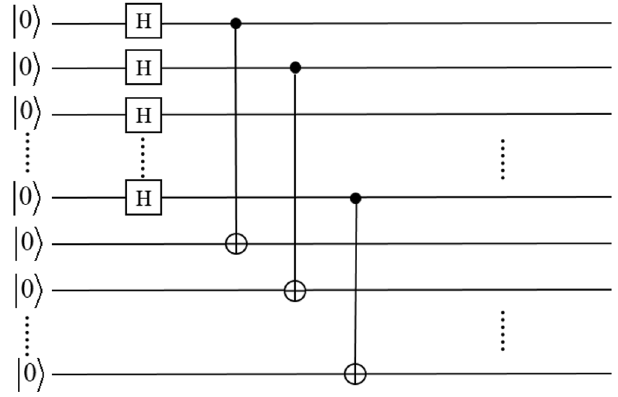
Figure 2. Quantum circuit for the preparation of the initial